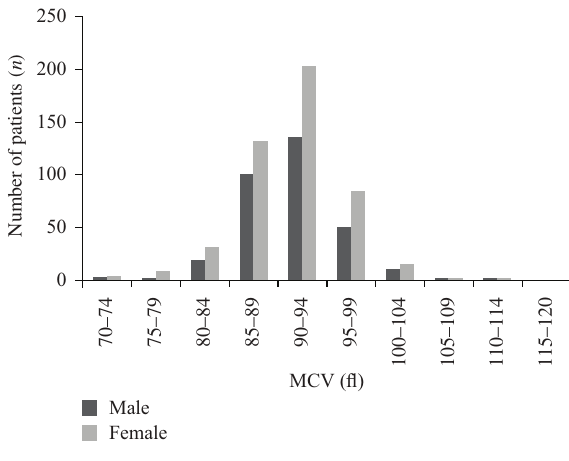
FIGURE 2: Distribution of patients undergoing total hip replacement by MCV and gender.